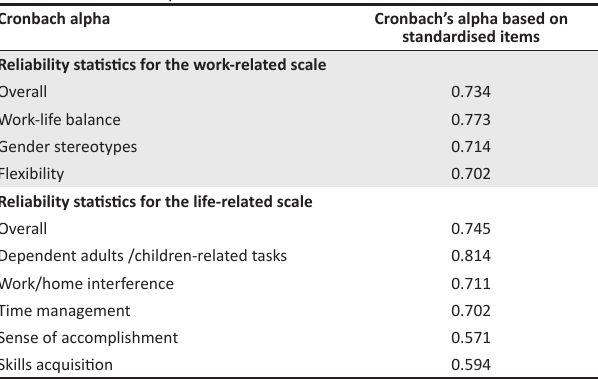
TABLE 1: Cronbach’s alphas for the scales and factors. Cronbach alpha